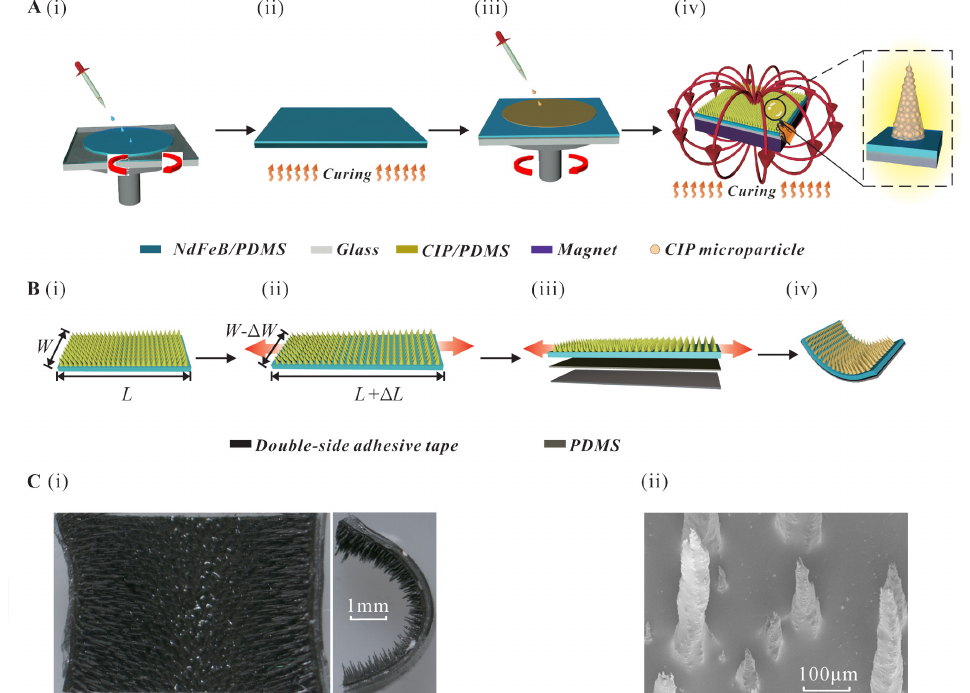
Figure 1. Fabrication process of the bionic magnetic inchworm robot. ( A ) Fabrication process of MAE with micropillars. ( i ) The NdFeB/PDMS composite is spin-coated onto a glass substrate to form the first layer of the MAE. ( ii ) The composite is cured under 150 ◦ C for 20 min. ( iii ) CIP/PDMS composite is spin-coated onto the first layer. ( iv ) The substrate is moved onto a permanent magnet ( ∼ 400mT) and cured under 40 ◦ C for 4 h. ( B ) Fabrication process of proposed bionic magnetic inchworm robot. ( i ) A piece of elastomer is cut from the fabricated MAE. ( ii ) The elastomer is stretched to length ∆ L with two ends fixed with two precise linear stages. ( iii ) Double-sided adhesive tape and PDMS substrate are spread onto the stretched MAE in sequence. ( iv ) Schematic diagram of the fabricated magnetic inchworm robot. ( C ) Optical image of the proposed bionic magnetic inchworm robot. ( i ) Microscope view of the fabricated magnetic inchworm robot. ( ii ) SEM image of the